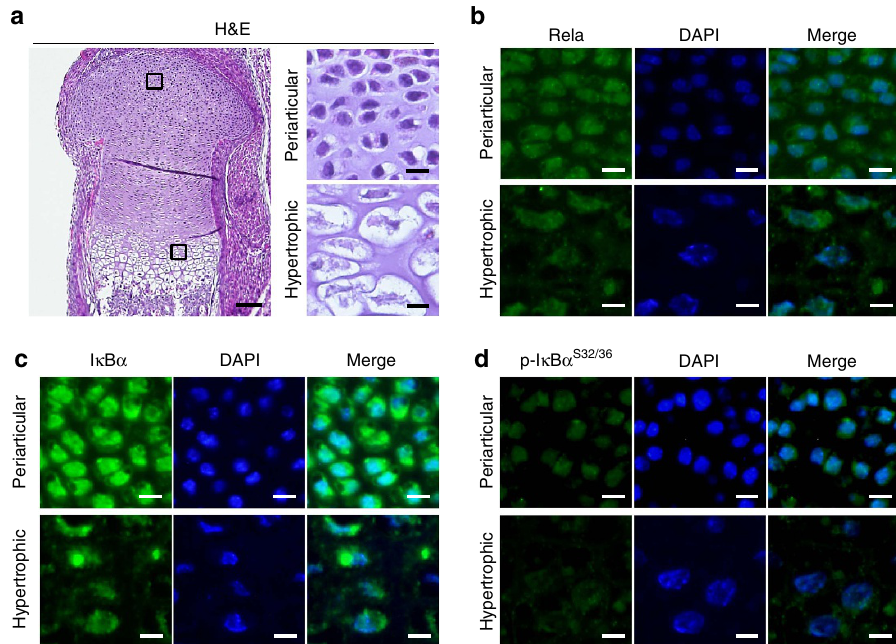
Figure 1 | Expression of Rela and I j B a in developing chondrocytes. ( a ) haematoxylin and eosin (H&E) staining of the epiphyseal cartilage of a mouse embryo (embryonic day ( e ) 18.5). Boxes in the left panel indicate enlarged images of the periarticular and hypertrophic zones. Scale bars, 100 and 10 m m for low and high magnification images, respectively. Immunofluorescence of Rela ( b ), I k B a ( c ), and Ser 32 and 36 dual phosphorylated I k B a ( d ) proteins in the periarticular and the hypertrophic zones. The images are representative of two independent experiments. Scale bars, 10 m